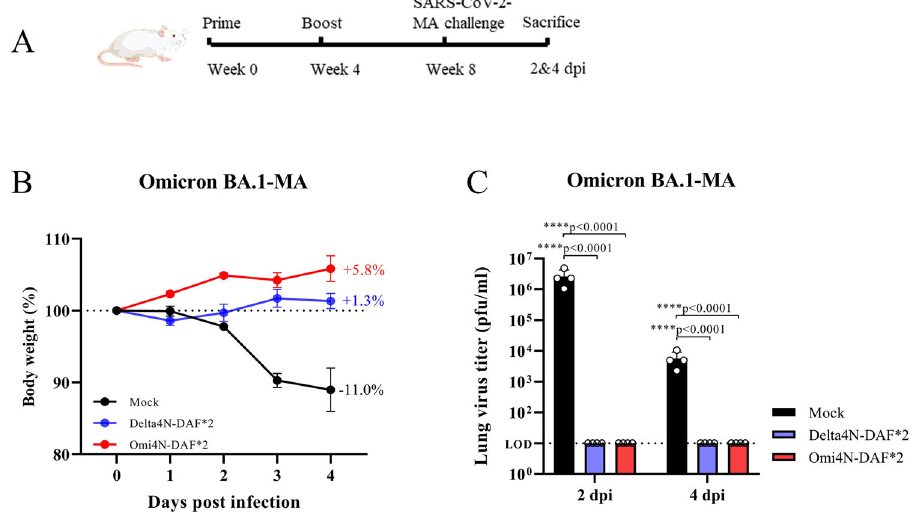
Fig.4|DelNS1-RBD4N-DAFLAIVsprotectmicechallengedwithmouse-adapted Omicron SARS-CoV-2 variant. A Illustration of schedule of immunization, SARS- CoV-2 virus challenge and sacri fi ce for BALB/c mice. 6 – 8-week-old BALB/c mice wereintranasallyprime-boostvaccinatedwithDelta4N-DAF(2×10 6 pfu)orOmi4N- DAF (2 × 10 6 pfu) or PBS ( n =8 for each group) and then challenged with a mouse- adapted Omicron BA.1 SARS-CoV-2 strain (Omicron-MA, 1×10 5 pfu) 4 weeks after